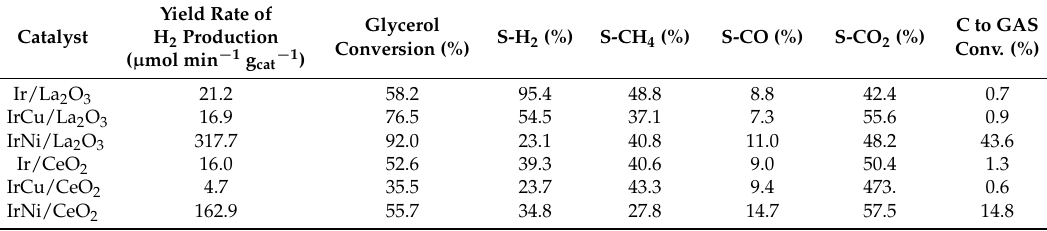
Table 3. APR performance of catalysts at 270 ◦ C and 58 bar. Average of six hours of